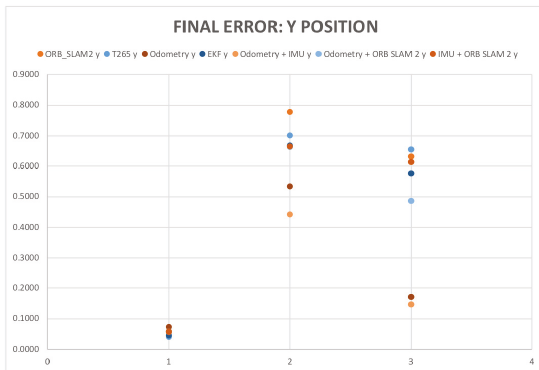
Figure 23. Indoor tests scenario 2. Test 1. Trials 1–5. Final error Y position.